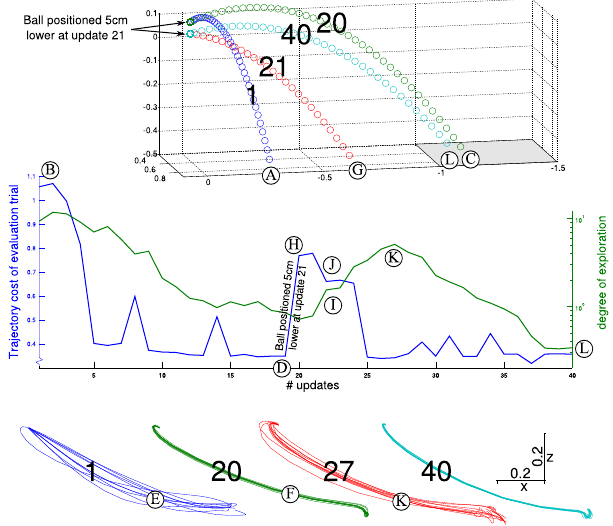
Figure 3. The center graph depicts the cost of the evaluation trial and the total exploration magnitude as learning progresses. The trajectories of the ball (top plot) and the trajectory of the end-point of the bat (bottom plot) after 1, 20, 21/27 and 40 updates.